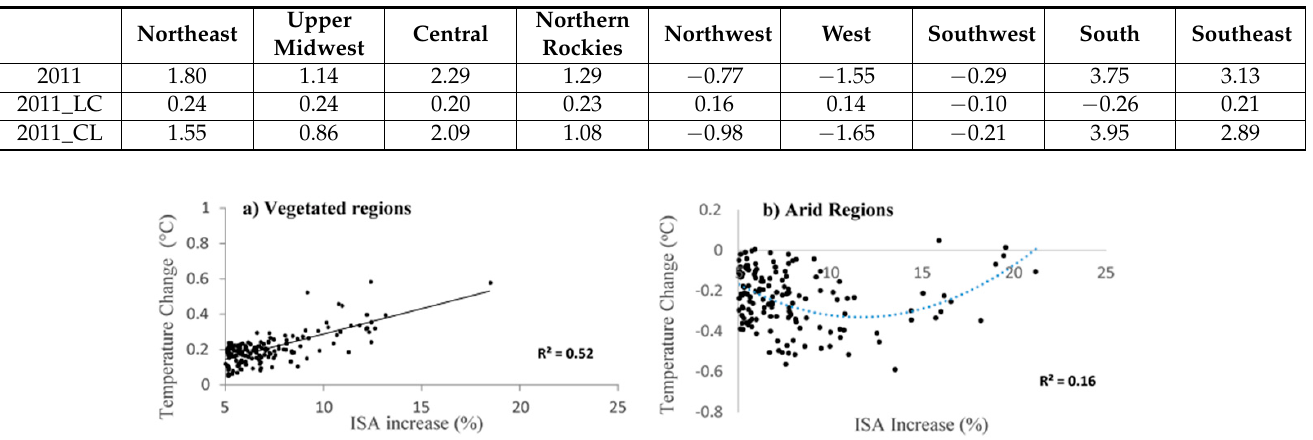
Figure 1. Relationship between modeled surface temperature (°C) and Impervious Surface Area (ISA) in CONUS urban centers built within, ( a ) vegetated regions and ( b ) arid regions (see text for details). Only CMGs with ISA greater than 5% are used.